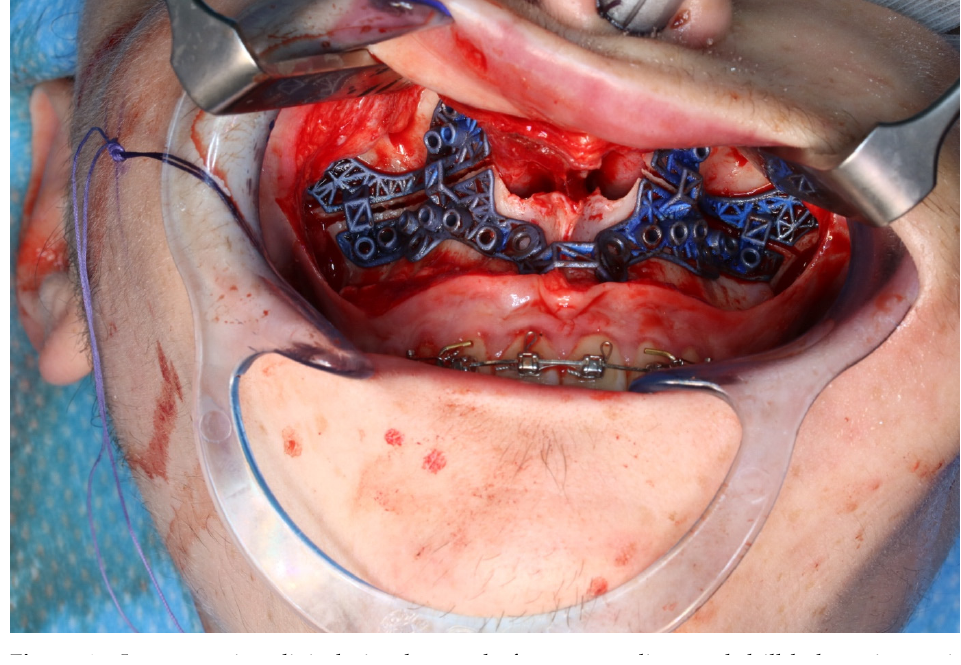
Figure 10. Intraoperative clinical visual control of osteotomy lines and drill holes using patient- specific cutting guide.